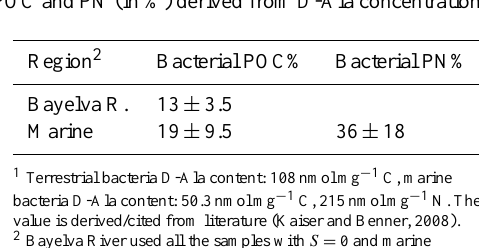
Table 4. Bacteria-contributed POC and PN proportion relative to bulk POC and PN (in %) derived from D-Ala concentrations 1 .